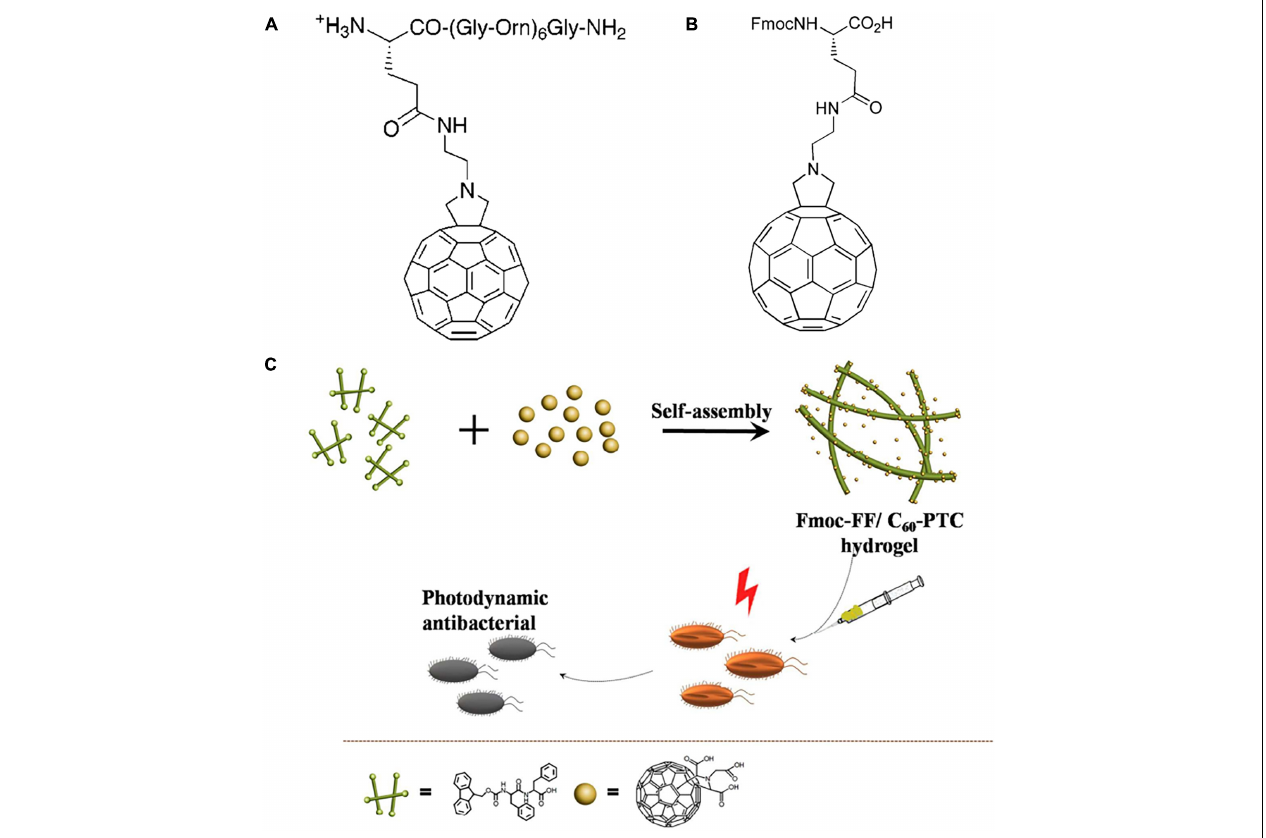
FIGURE 6 | (A) The molecular structure of C 60 -functionalized amino acid with N-Fmoc-L-glutamic acidr-tert-butyl ester (Pellarini et al., 2001). (B) The molecular structure of Fgu (Pantarotto et al., 2002). (C) Schematic diagram of Fmoc-FF/C 60 -PTC hydrogel (Zhang et al., 2018).